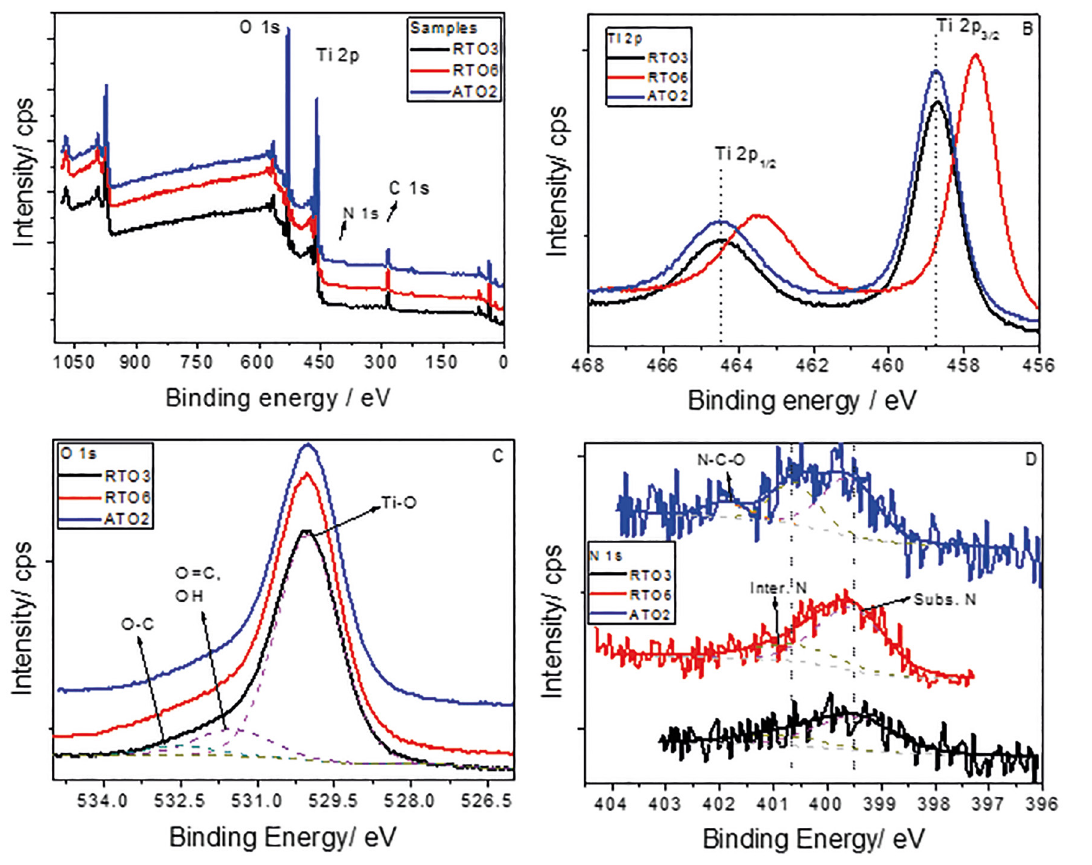
Figure 6. (a) XPS spectra of the RTO-3, RTO-6 and ATO-2 samples; (b) high-resolution Ti 2p XPS spectra; (c) high-resolution O 1s XPS spectra; (d) high-resolution N 1s XPS spectra. of substitutional and interstitial N could lead to improved photocatalytic